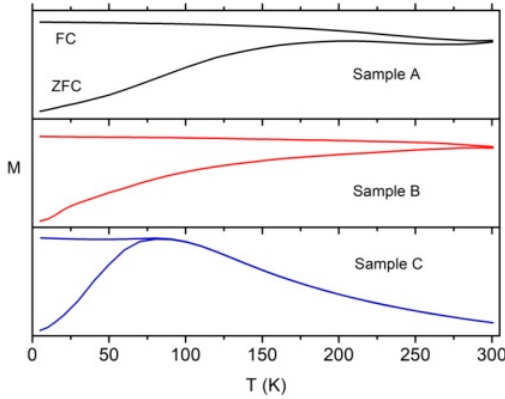
Figure 6. ZFC and FC curves measured for the three samples.